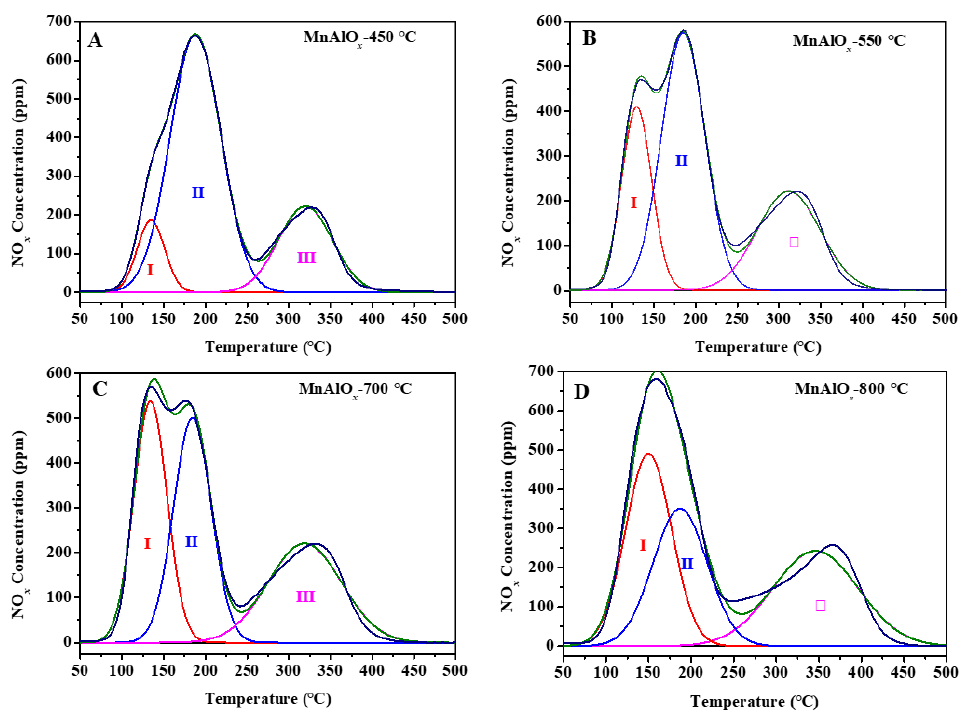
Figure 8. NO + O 2 -TPD profiles of ( A ) MnAlO x -450 °C, ( B ) MnAlO x -550 °C, ( C ) MnAlO x -700 °C, ( D ) MnAlO x -800 °C.